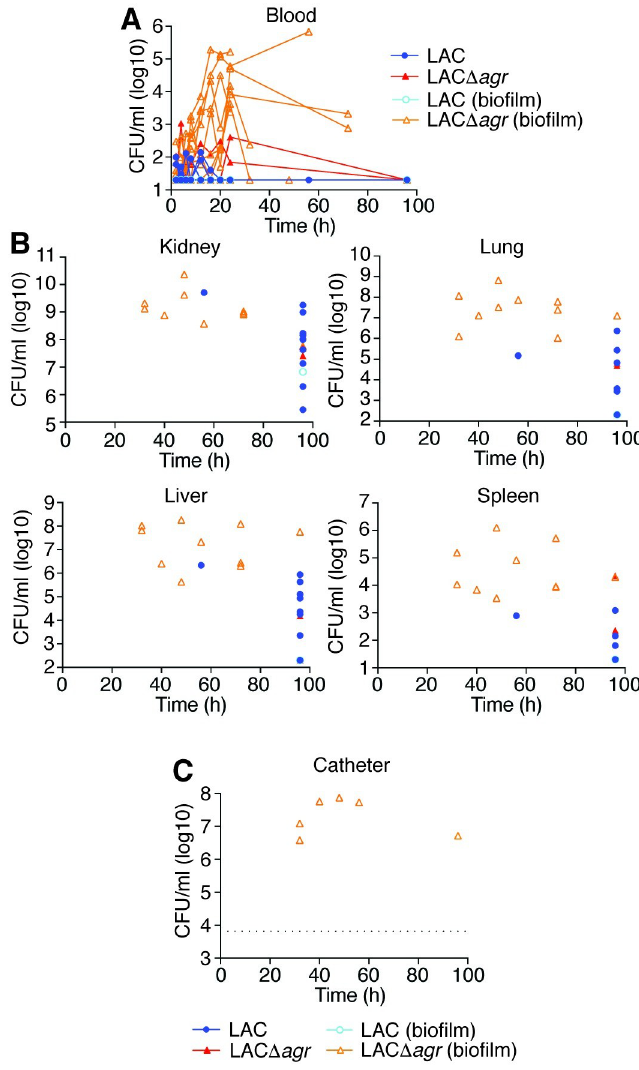
Fig 4. Rabbit catheter-associated sepsis model–CFU in blood, organs, and on catheters. ( A ) Bacterial CFU in the blood over time. ( B ) Bacterial CFU at the time of death or the end of the experiment in the indicated organs. ( C ) Bacterial CFU in the lumina of implanted catheters. Data are from the second batch of rabbits only (n = 6/group). The dotted line depicts the threshold above which CFU values were considered to reflect biofilm formation in both batches of rabbits. ( A-C ) Rabbits that developed catheter biofilms are marked by open symbols and light-colored borders.